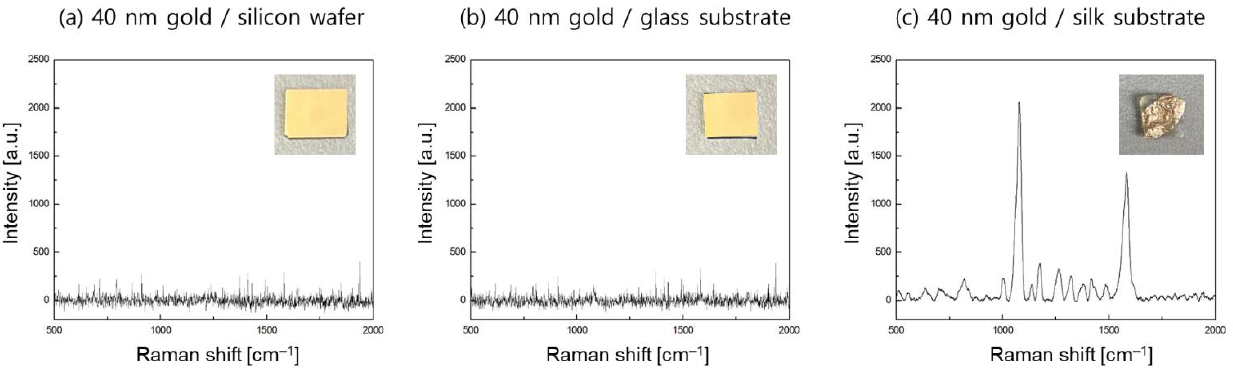
Figure 2. SERS experiments of 4-ABT analytes at a concentration of 10 µ M for ( a ) a 40 nm thick gold film on a silicon wafer, ( b ) a 40 nm thick gold film on a BK7 glass, and ( c ) a 40 nm thick gold film on a porous silk substrate.